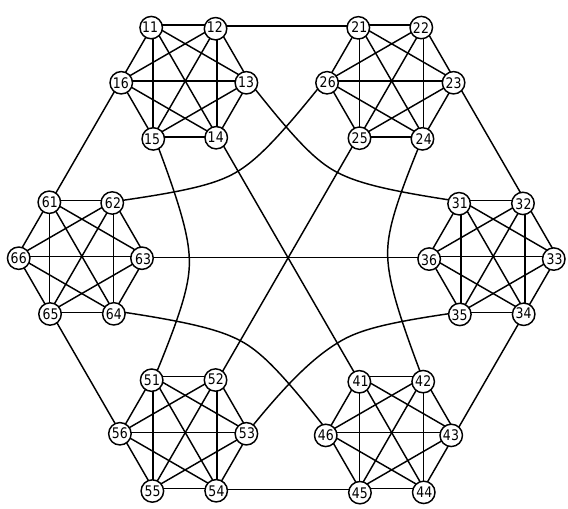
Figure 1: OTIS swapped network O K